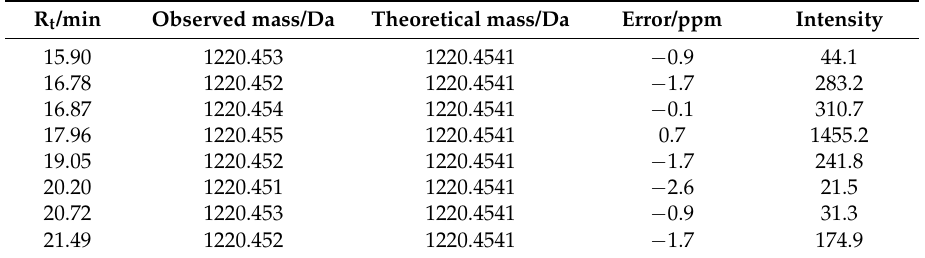
Table 4. Partial library of eight structures. Reproduced with permission from [7]. Copyright American Chemical Society, 2010.